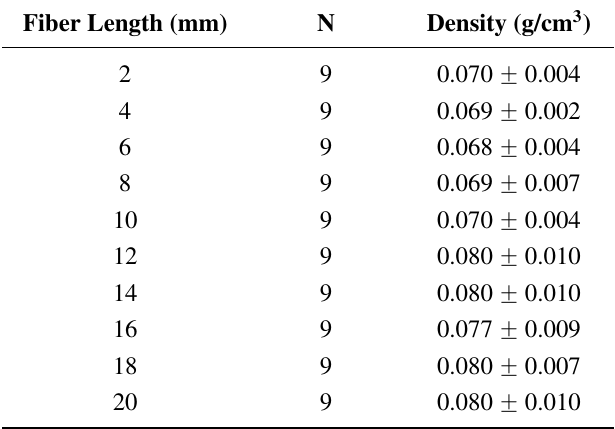
Figure 3. Cross sections of soy silk samples, 2–20 mm fiber lengths, uncut samples in bottom row. Table 1. Average densities for each fiber length of the hemp compression series samples.